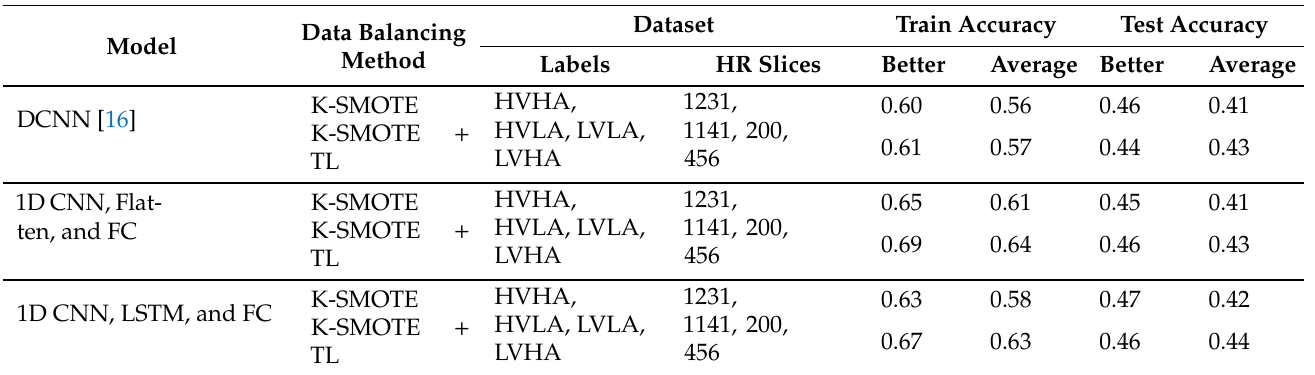
Table 4. ES dataset performance with CNN-based ER models and four-class balancing methods.